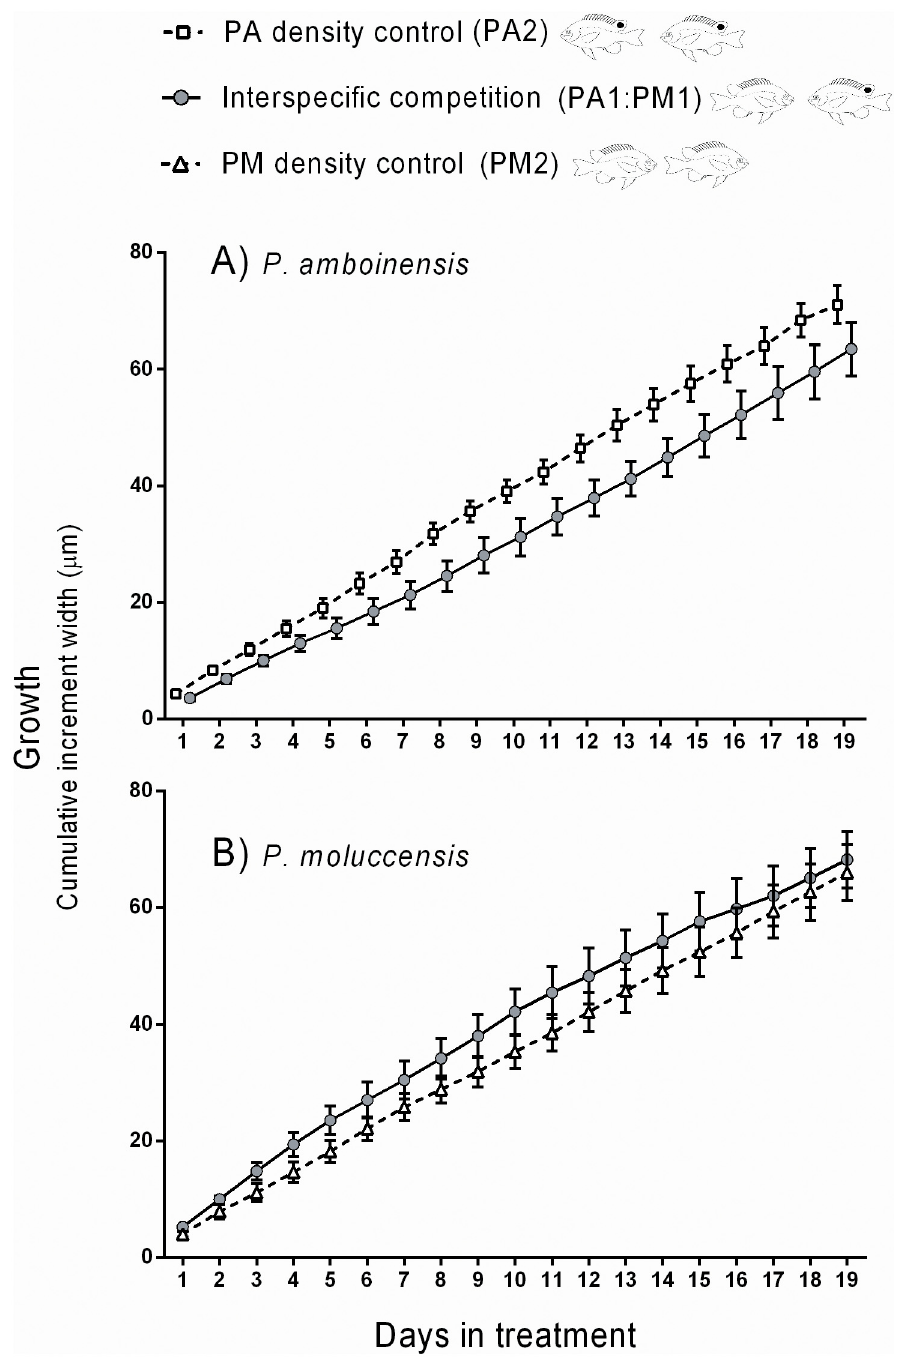
Fig 2. Growth (mean cumulative otolith increment width ± 1 SE) of A) P . amboinensis and B) P . moluccensis during the experimental period according to competitor treatment, with no predator present. Paired conspecific treatments (PA2 and PM2) are controls for the paired heterospecific (interspecific competition) treatment (PA1:PM1). PA = P . amboinensis , PM = P . moluccensis .